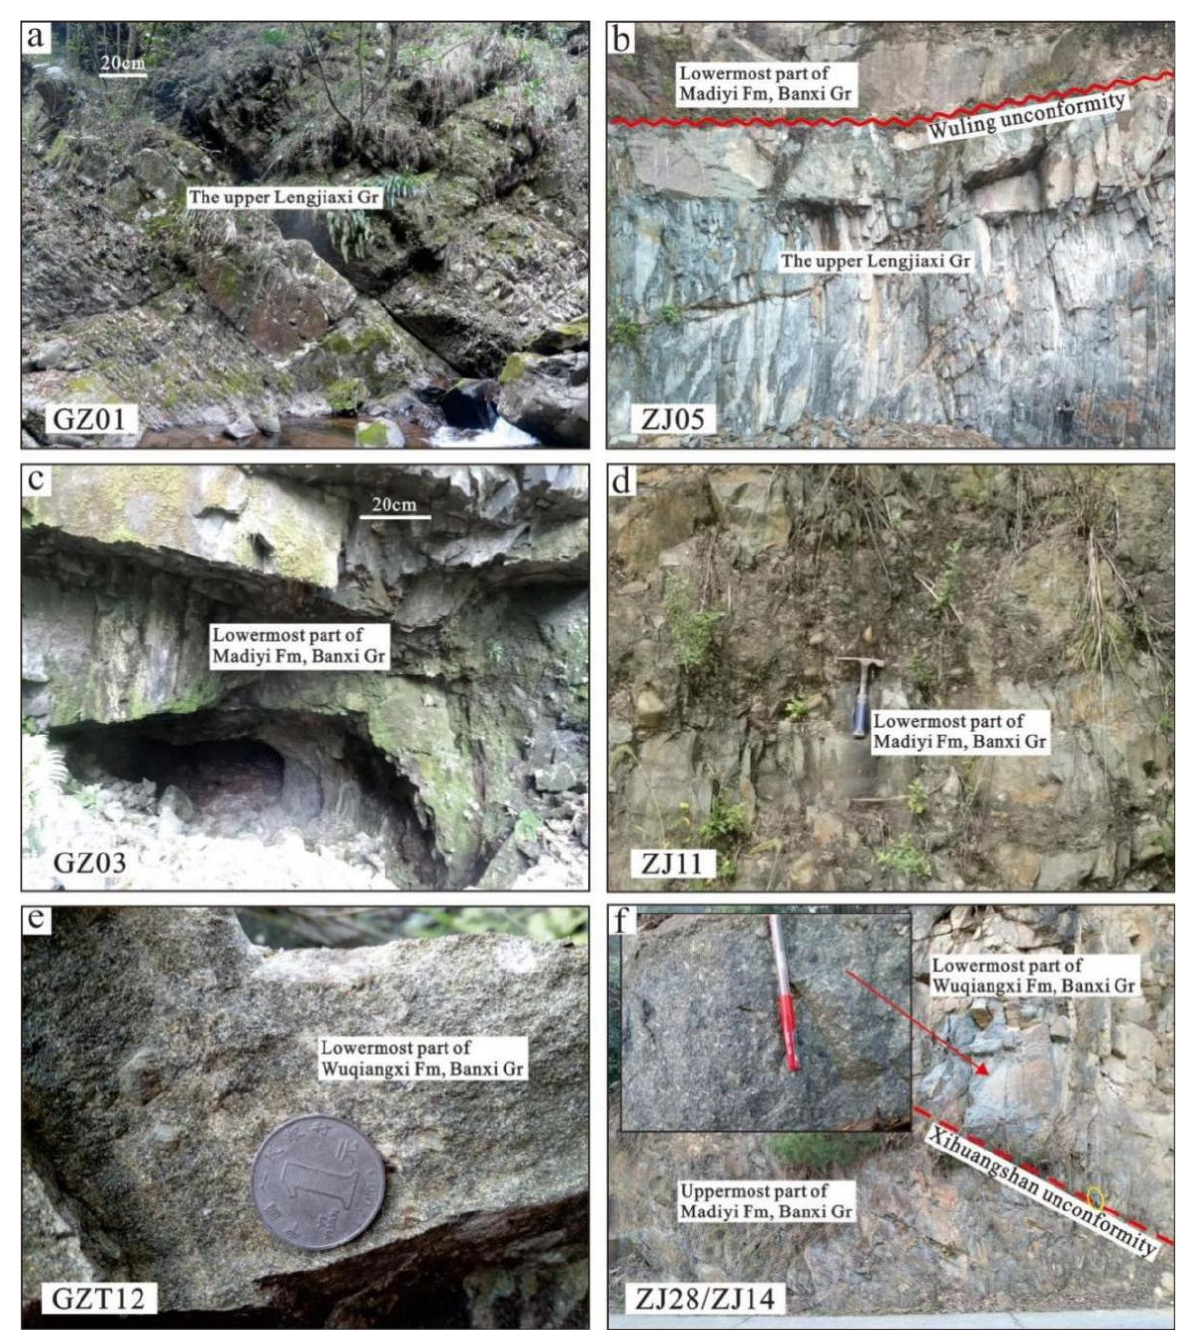
Figure 3. Field photographs showing the outcrops of the Lengjiaxi and Banxi groups in the Guzhang and Zhijiang areas. ( a ) Fine-grained lithic sandstone at the upper part of the Lengjiaxi Group in Guzhang County; ( b ) Wuling angular unconformity between the underlying Lengjiaxi Group and overlying Banxi Group in Zhijiang County; ( c ) fine-grained lithic sandstone at the the bottom of the Madiyi Formation in Guzhang County; ( d ) conglomerate interbedded with medium-grained lithic sandstone at the bottom of the Madiyi Formation in Zhijiang County; ( e ) pebbly lithic quartz sandstone at the the bottom of the Wuqiangxi Formation in Guzhang County; ( f ) sandy conglomerate at the bottom of the Wuqiangxi Formation above the Xihuangshan unconformity.